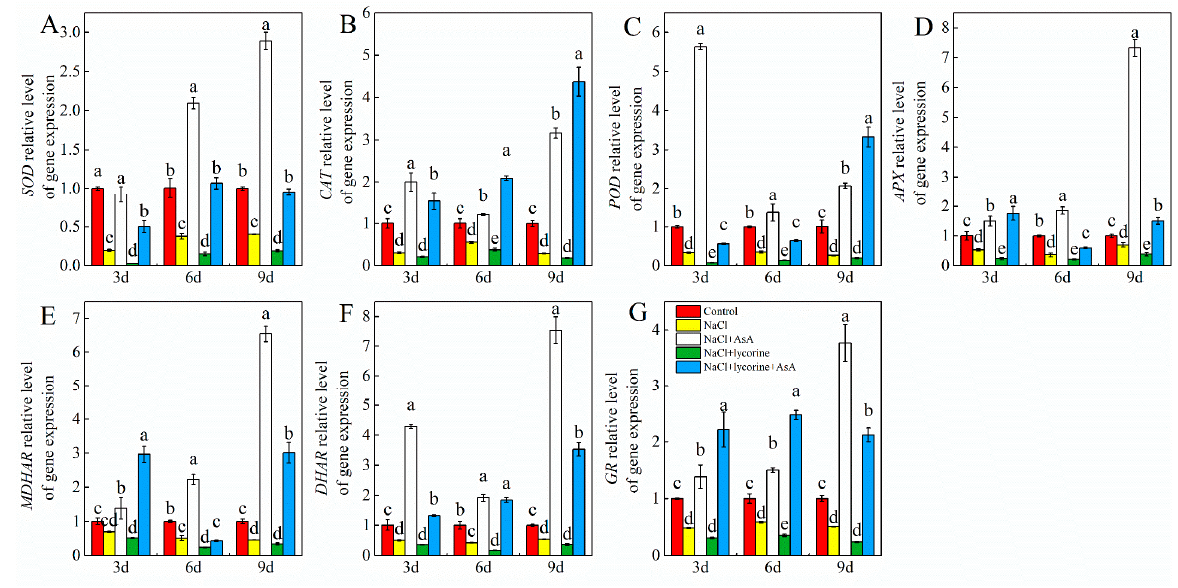
Figure 11. Expression of SOD (superoxidase dismutase gene) ( A ), CAT (catalase gene) ( B ), POD (peroxidase gene) ( C ), APX (ascorbate peroxidase gene) ( D ), MDHAR (monodehydroascorbate reductase gene) ( E ), DHAR (dehydroascorbate reductase gene) ( F ), and GR (glutathione reductase gene) ( G ) genes in leaves of salt-stressed tomato seedlings with or without exogenous reduced ascorbic acid (AsA) and lycorine (AsA synthesis inhibitor) spraying. Abbreviations 3d, 6d, and 9d represent the third, sixth, and ninth day after treatment, respectively. Control, no added NaCl and sprayed with distilled water; NaCl, addition of 100 mmol · L –1 NaCl and sprayed with distilled water; NaCl + AsA, added 100 mmol · L –1 NaCl and sprayed with 0.5 mmol · L –1 AsA; NaCl + lycorine, added 100 mmol · L –1 NaCl and sprayed with 0.25 mmol · L –1 lycorine; NaCl + lycorine + AsA, added 100 mmol · L –1 NaCl and sprayed with 0.25 mmol · L –1 lycorine plus 0.5 mmol · L –1 AsA. Values are means ± SD ( n = 3). Values with a different letter within a sampling date are significantly different ( p <